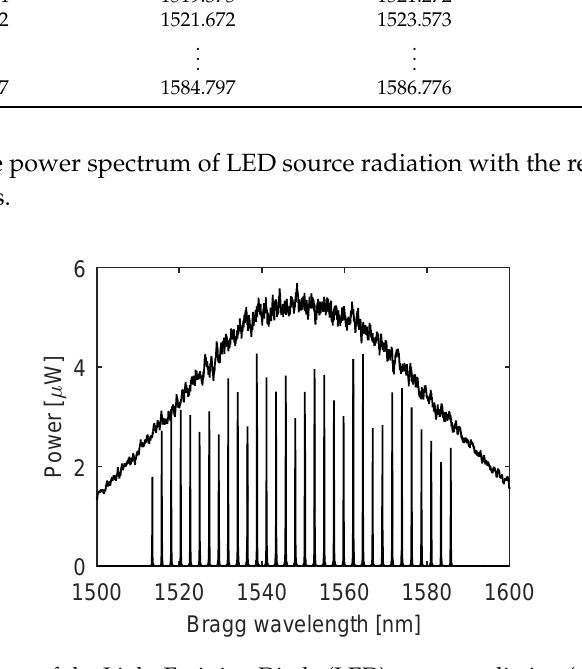
Figure 6. The spectrum of the Light Emitting Diode (LED) output radiation (upper graph) and the spectral distribution of the fiber Bragg gratings in the sensor array (lower